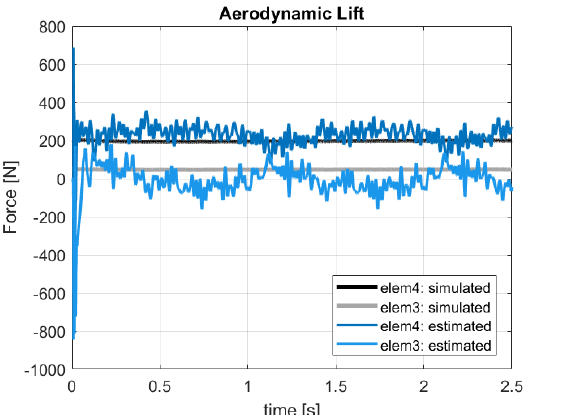
Figure 8. Estimation of the unmeasured velocity and position entities with reference to the sensor layout in Table 2. Reference noisy data.